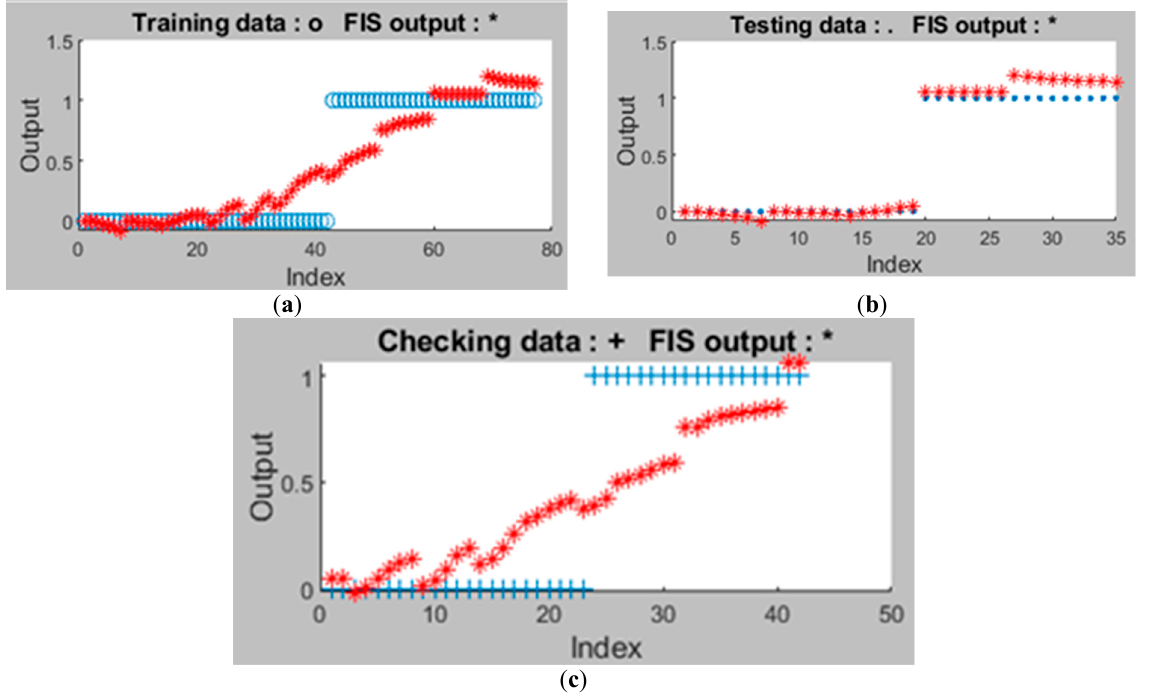
Figure 26. Deviations in FIS output and input data for ( a ) training, ( b ) testing and ( c ) checking.